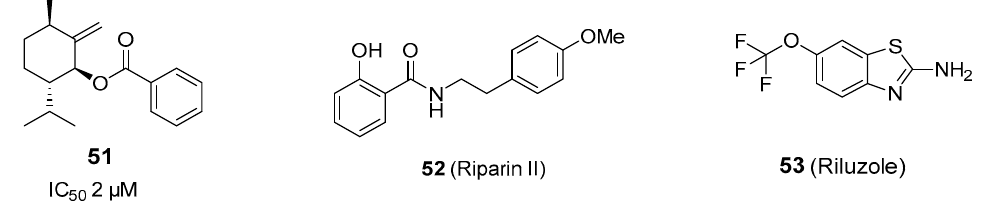
Figure 5. Natural product-derived and marketed drug TRPM8 antagonists.